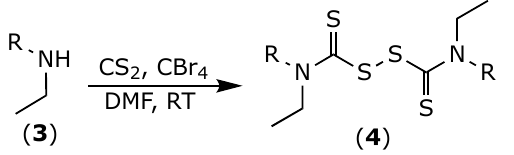
Figure 2. Chemical synthesis of disulfiram analogues ( 4 ).